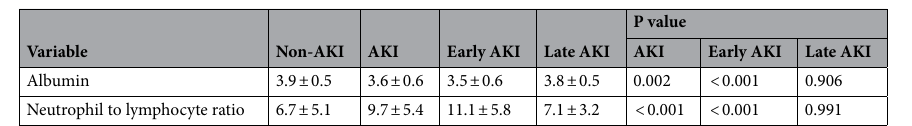
Table 5. Laboratory findings in each group. P value: vs non-AKI. AKI: acute kidney injury.